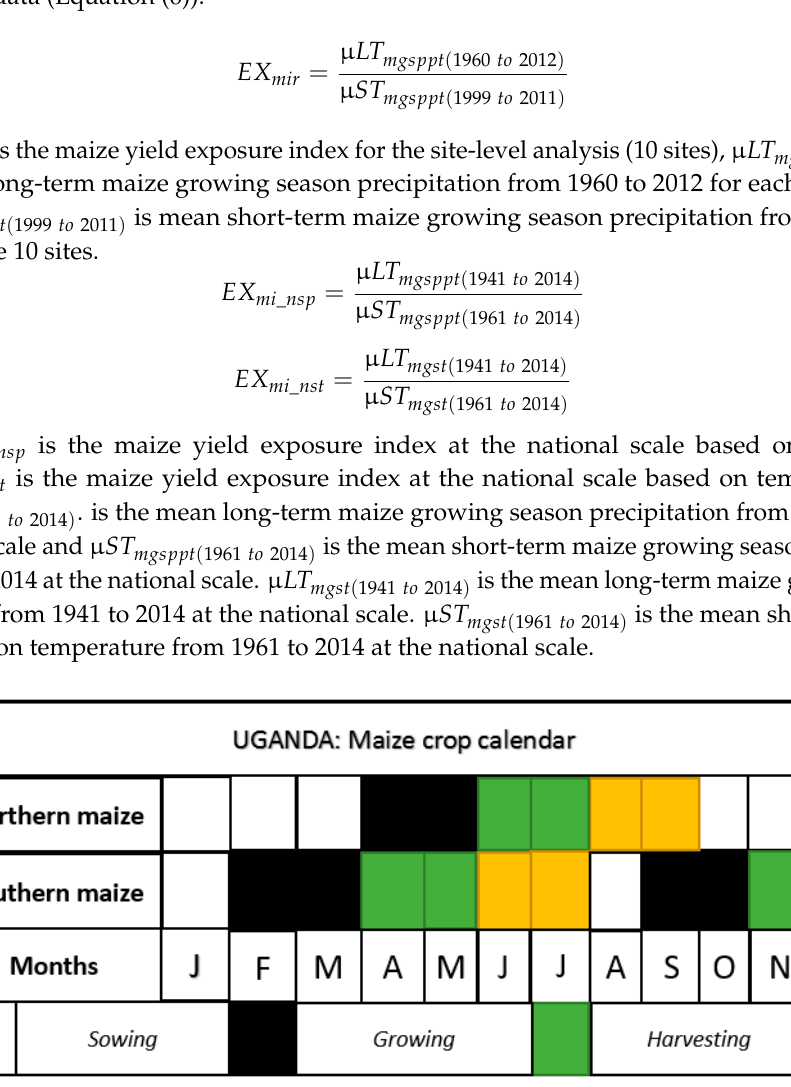
Figure 2. Maize crop calendar for Uganda. Source: the authors’ conceptualization inspired by FAO [63].